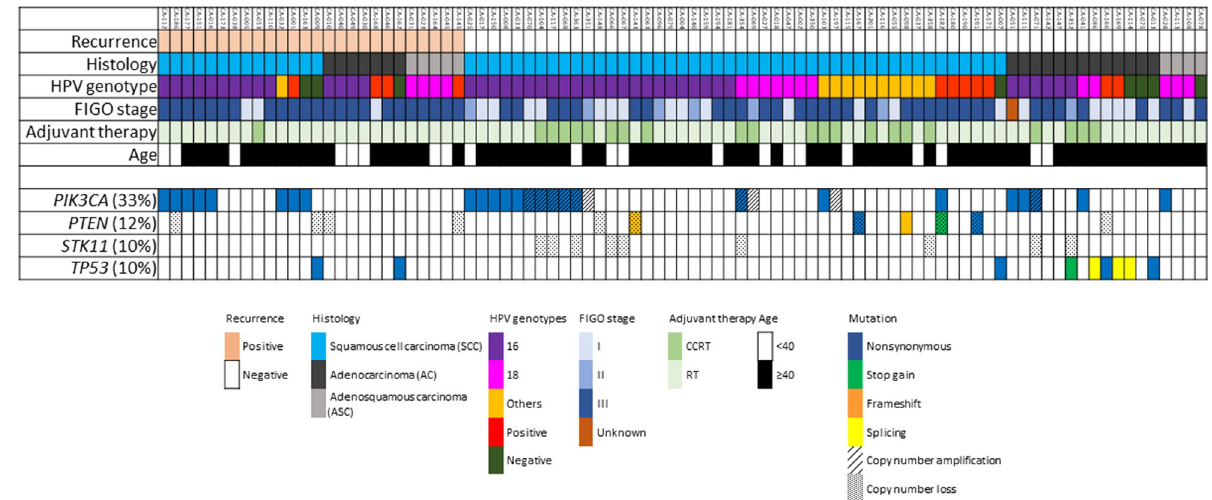
Figure 2. An overview of clinicopathological status and clinical outcomes of all patients included in this study. Rec